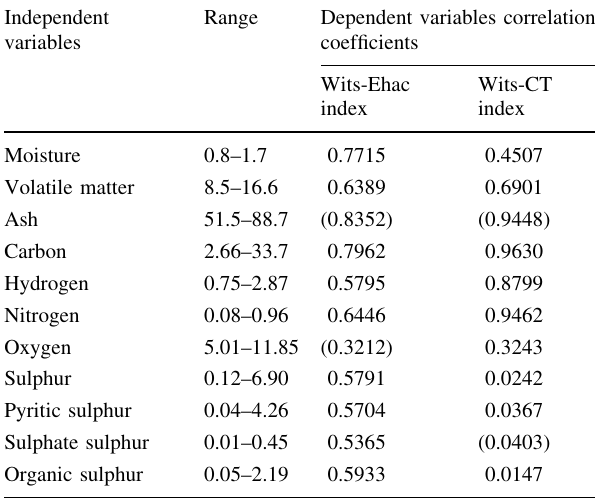
Table 5 Relationships between independent (proximate and ultimate analysis, wt%-ad) and dependent variables for coal-shale samples Independent variables